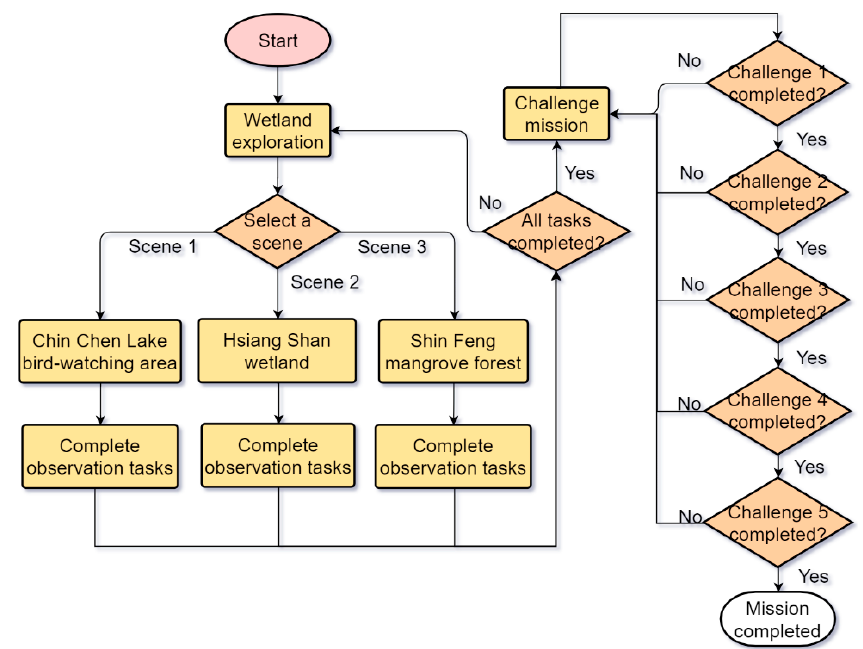
Figure 6. Operating process of the virtual wetland ecological system.